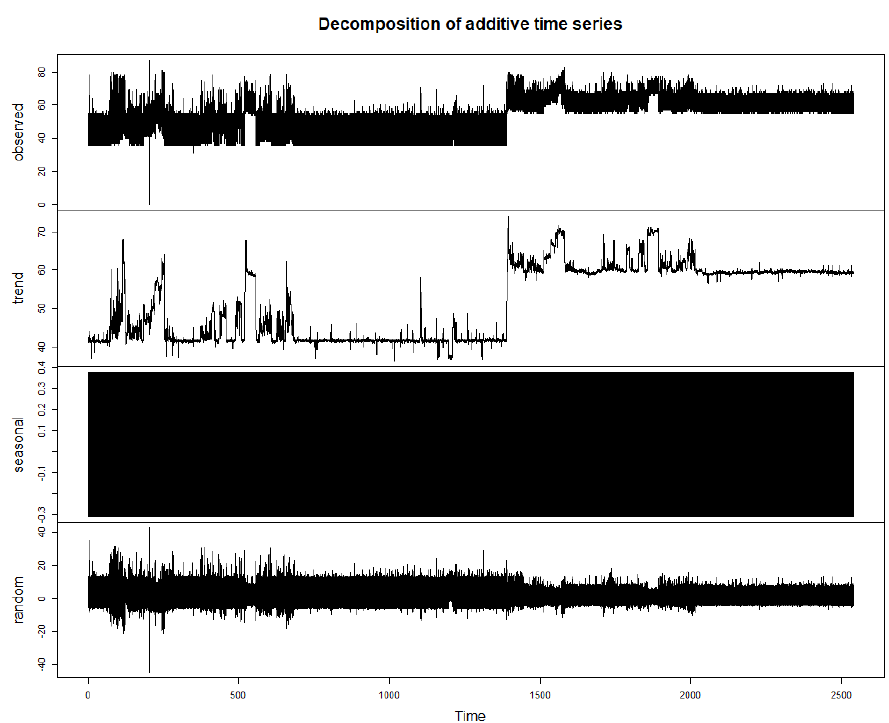
Figure 5. Decomposition of the time series dataset.